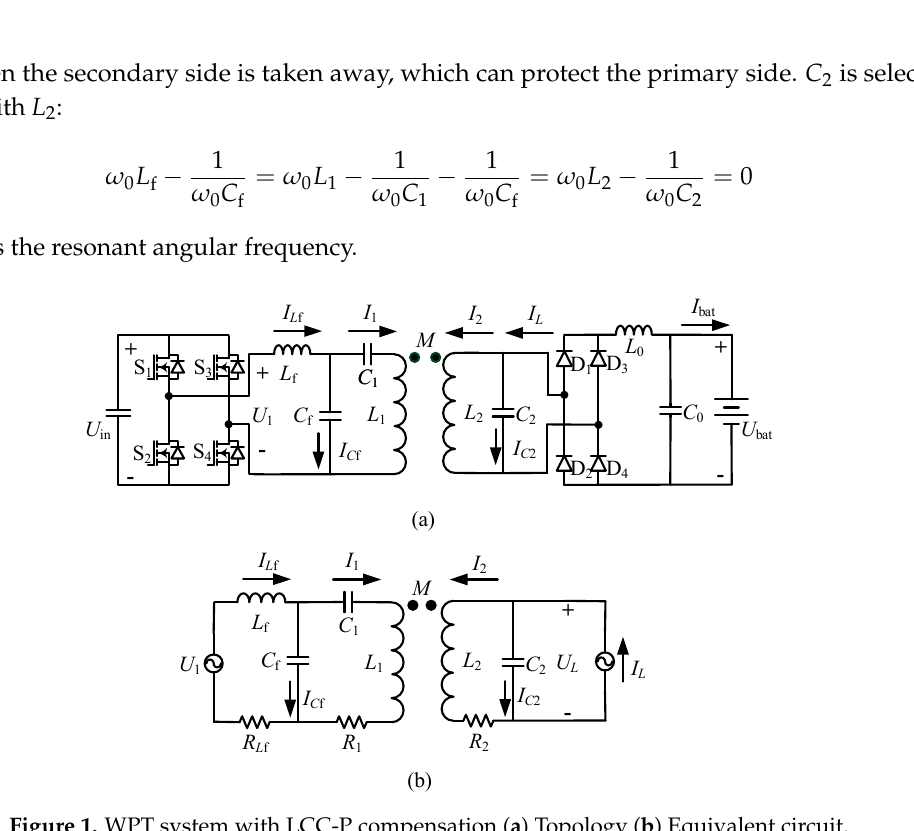
Figure 1. WPT system with LCC-P compensation ( a ) Topology ( b ) Equivalent circuit.